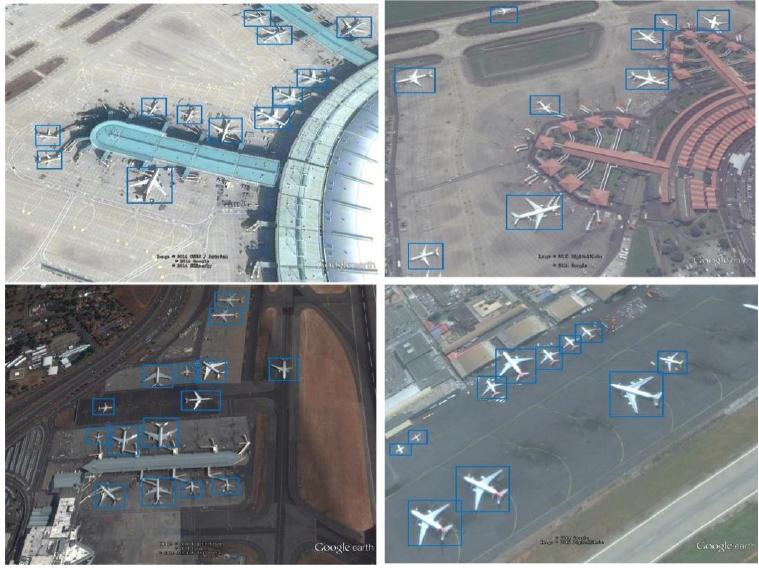
Figure 4. Examples of training data.